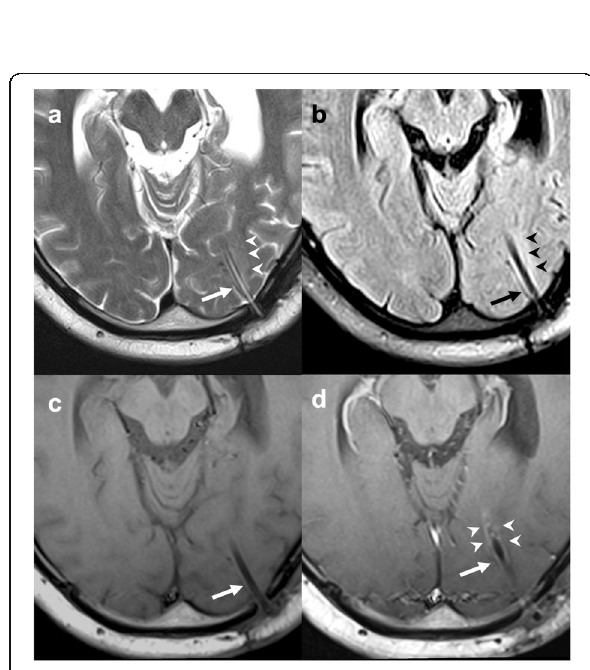
Fig. 7 Ventricular catheter. Axial T2-weighted ( a ), FLAIR ( b ), unenhanced ( c ), and post-contrast ( d ) T1-weighted images presenting a left occipital access ventricular catheter (arrows) with mild peripheral gliosis (arrowheads in a and b ) and subtle enhancement (arrowheads in d